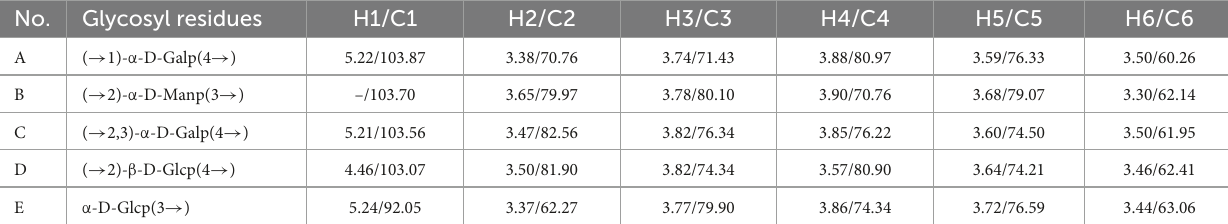
TABLE 2 Chemical shifts of resonances in the 1 H NMR and 13 C NMR spectra of